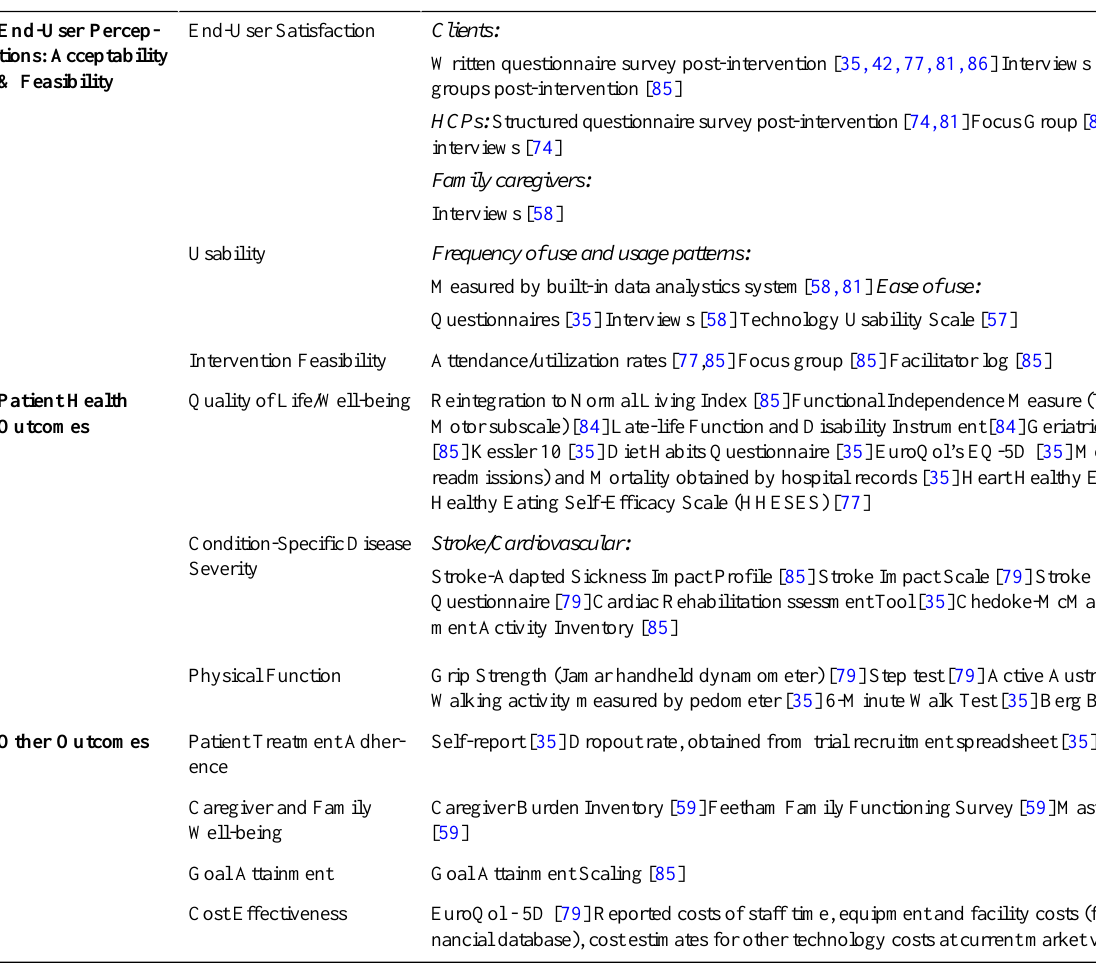
Table 2. Constructs measured in mHealth studies